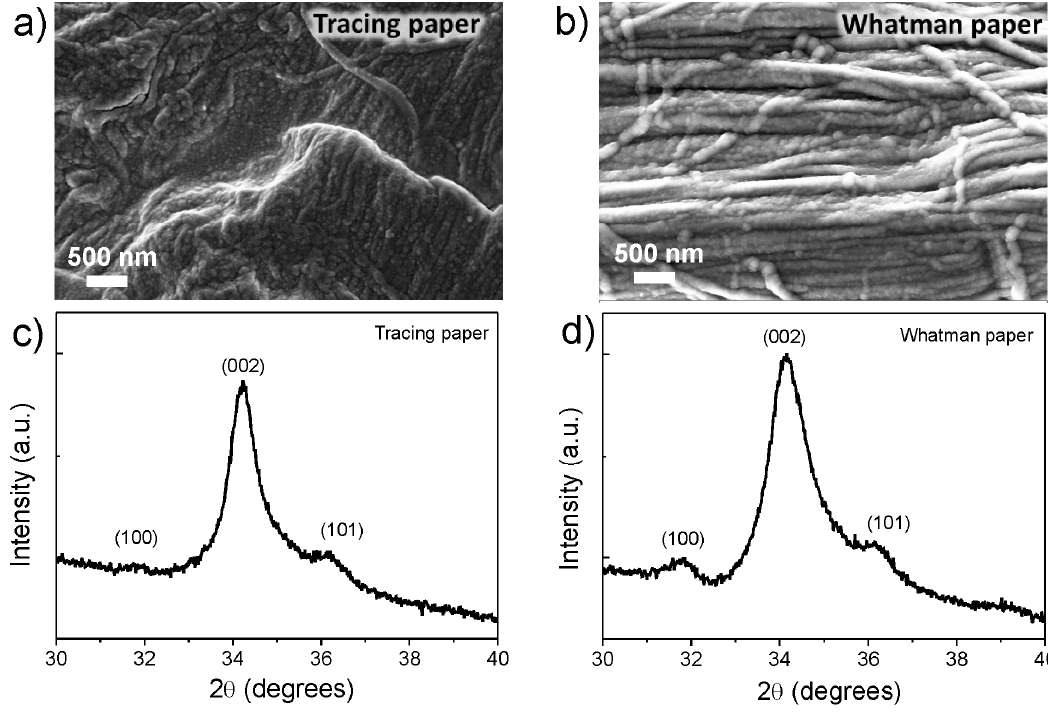
Figure 3. ( a , b ) SEM images and ( c , d ) XRD diffractograms of zinc oxide (ZnO) seed layer, deposited by sputtering technique on tracing and Whatman paper substrates, respectively.